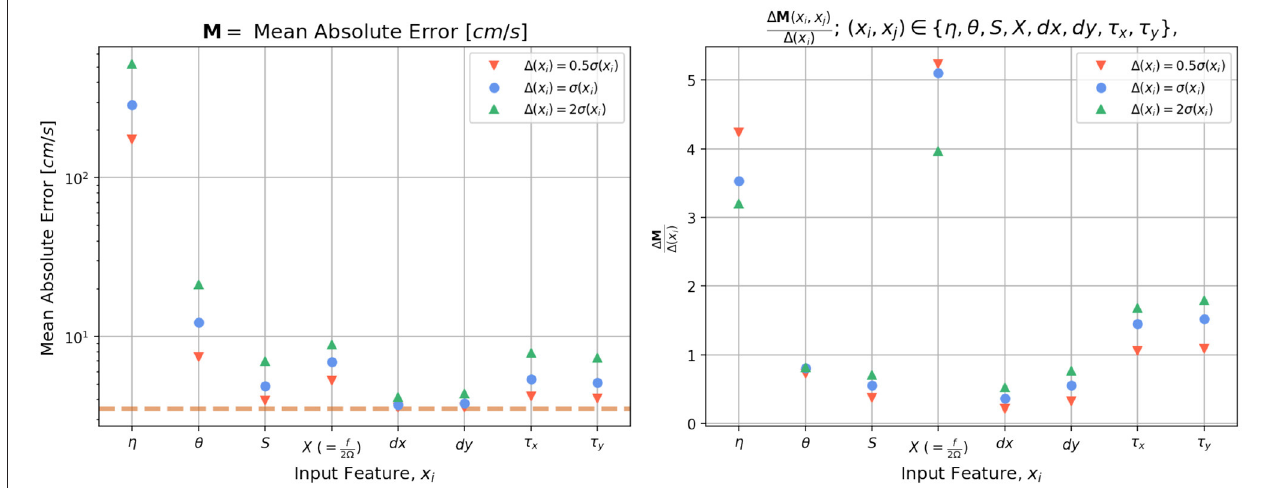
FIGURE 10 | Sensitivity of the neural networks to perturbations in the different input features. Each input feature is perturbed by three different Gaussian noise perturbations with standard deviations of 0.5 σ , σ , and 2 σ , where σ is the standard deviation of each variable, while keeping the remaining input variables fixed. The left panel shows the model loss (mean absolute error, MAE) evaluated for each of these perturbations. The horizontal dashed line represents the loss for the unperturbed/control case. The right panel shows the deviation in MAE for each of these perturbation experiments normalized by the amplitude of the